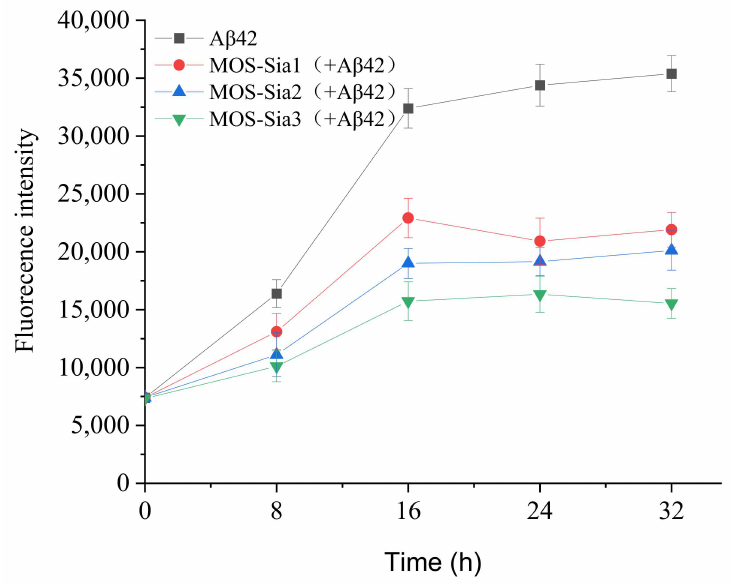
Figure 3. Fluorescence detection of the effect of MOS-Sia on A β 42 aggregation by ThT staining. Data are shown as the mean ± SD of